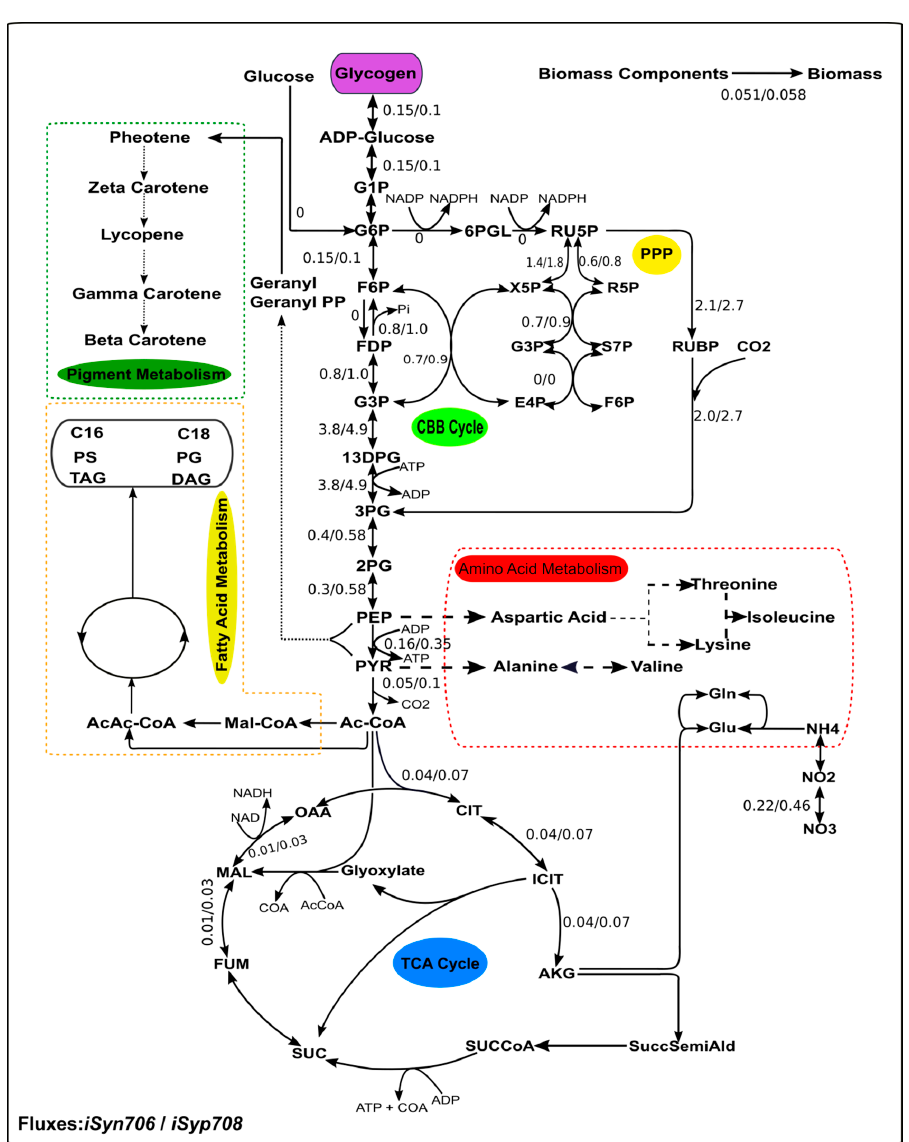
Figure 6. Simulated Flux map under photoautotrophic condition for i Syn706 and i Syp708 models. The growth rates of both the models were fixed to the experimentally determined values of 0.051 h − 1 and 0.058 h − 1 for i Syn706 and i Syp708, respectively while minimisation of the total fluxes was chosen as the objective function during simulations.